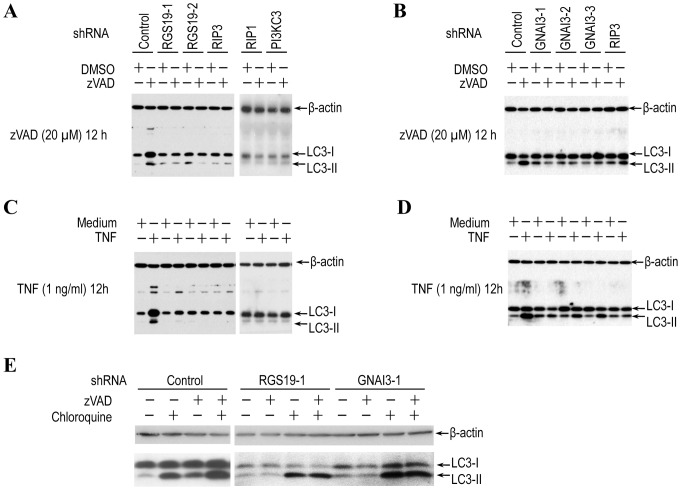
Knockdown of RGS19 or GNAI3 inhibits both zVAD- and TNF-induced autophagy.(A–B) Knockdown of RGS19 or GNAI3 inhibited zVAD-induced modification of LC3. Control and RGS19-knockdown (A) or GNAI3 knockdown (B) L929 cells were treated with mock or zVAD (20 µM) for 12 h. Cell lysates were subjected to western blot analysis with antibodies against LC3 and β-actin. Results from RIP1- or PI3KC3-knockdown cells were included as controls. (C–D) Knockdown of RGS19 or GNAI3 inhibited TNF-induced modification of LC3. Control and RGS19-knockdown (C) or GNAI3 knockdown (D) L929 cells were treated with mock or TNF (1 ng/ml) for 12 h. Cell lysates were subjected to western blot analysis with the indicated antibodies. (E) Knockdown of RGS19 or GNAI3 impaired zVAD-induced LC3 flux. Control and RGS19-knockdown or GNAI3-konckdown L929 cells were cultured with or without chloroquine (25 µM) and treated with or without zVAD (20 µM) for 12 h. LC3 levels were measured by Western blot.